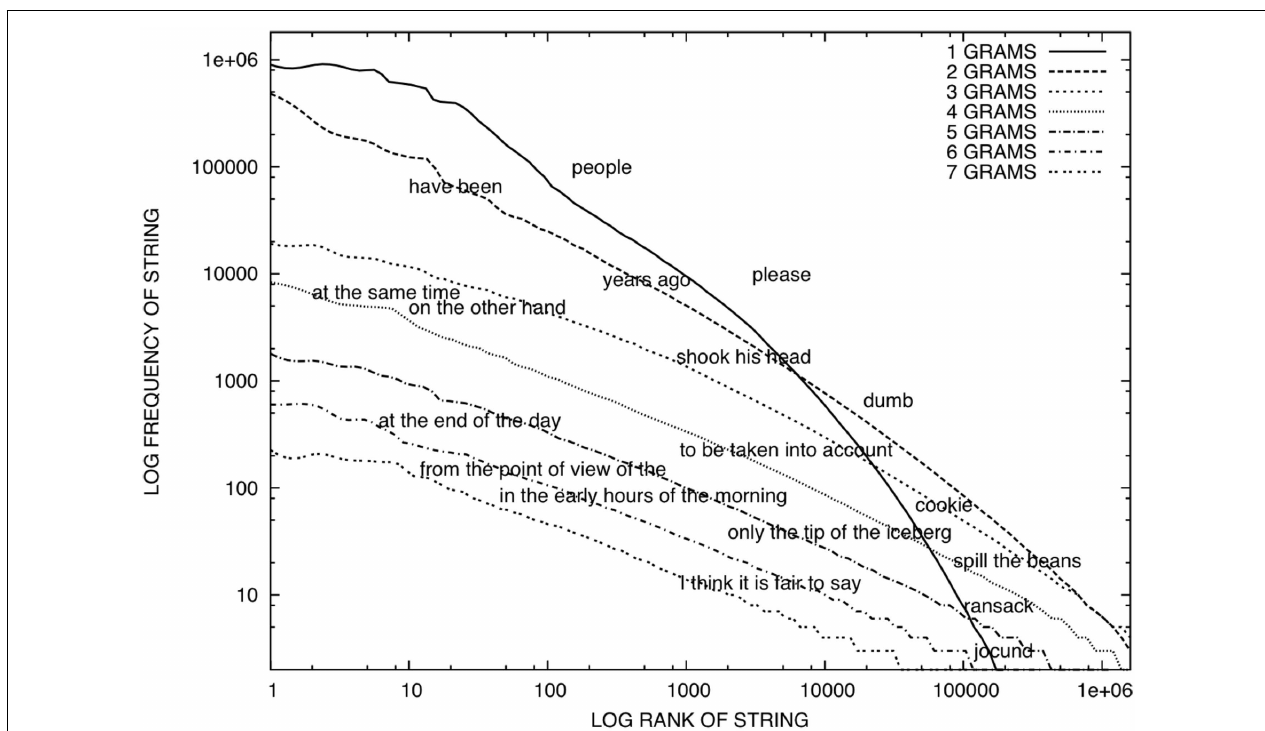
FIGURE 2 | From Bannard and Lieven (2009). The figure plots the natural logarithm of the frequency of each string of words encountered against the natural logarithm of the position of each string in a ranked list of these substrings.Words are taken from the 89 million word written component of the British National Corpus (Burnard,